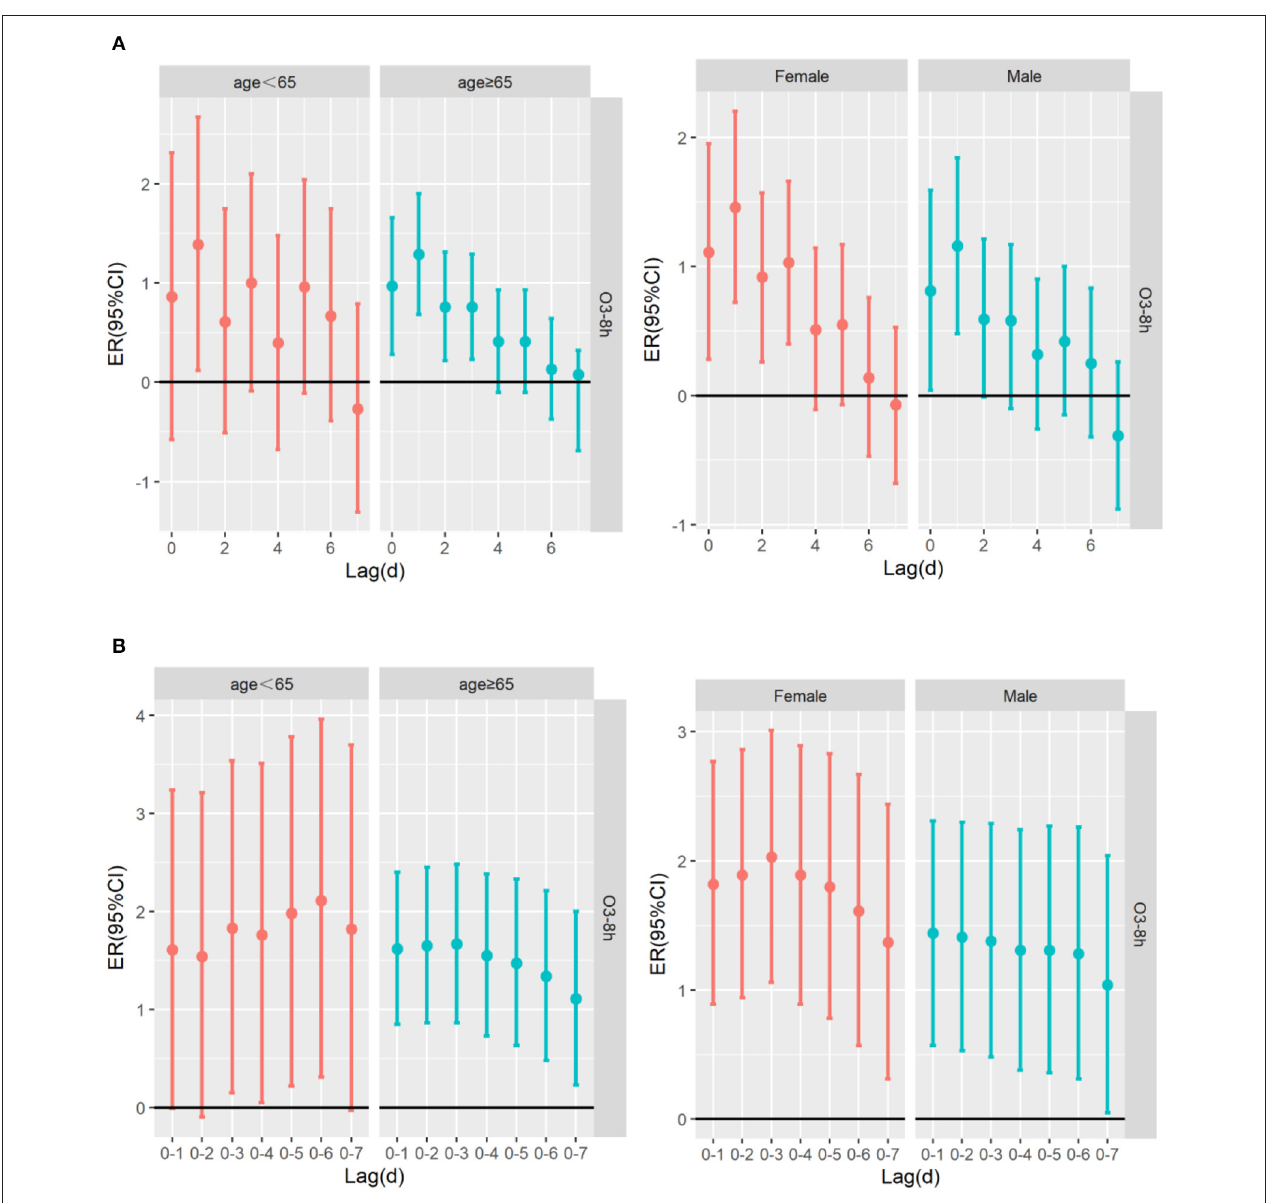
FIGURE 6 | The ER (95%CI) of cardiovascular mortality in age and sex lag-response relationship associated with 10 µ g/m 3 increase of O 3 -8h concentration; (A) The risk of cardiovascular mortality associated with 10 µ g/m 3 increase of O 3 -8h; (B) The cumulative risks of cardiovascular mortality associated with 10 µ g/m 3 increase of O 3